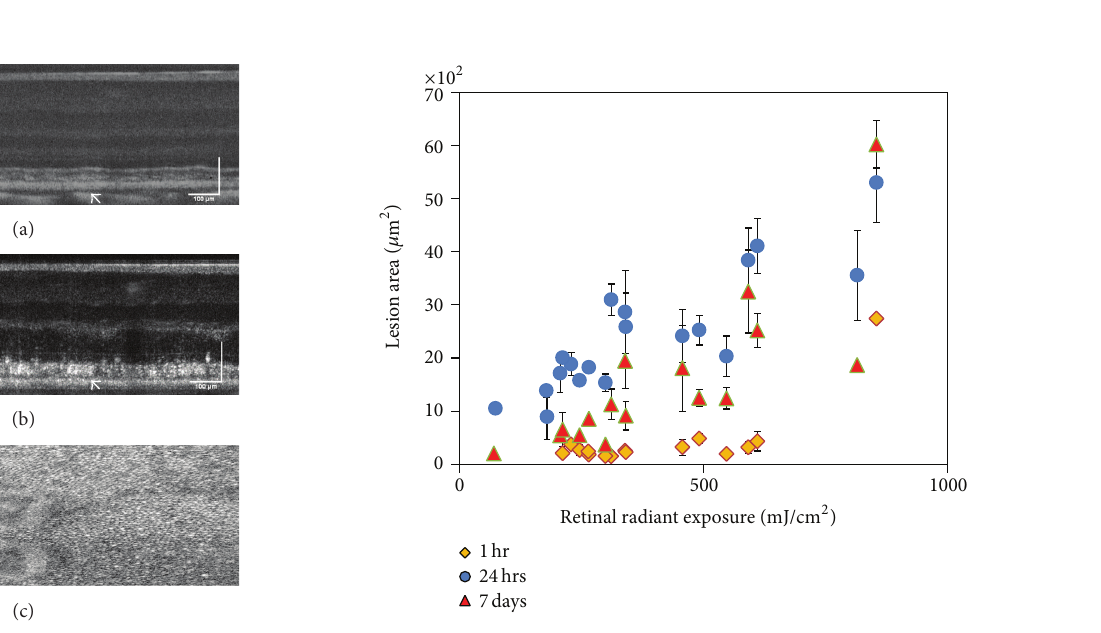
Figure 3: Formation of a lesion in the retina of subject S3 immediately after a high energy retinal radiant exposure (870 mJ/cm 2 ). The lesion (white arrows) became more reflective in the minutes following exposure and is likely associated with edema. OCT B-scans of photothermal exposure moments before (a), approximately 10 seconds after (b), and minutes later (c). Scale bar: 100 𝜇 m.